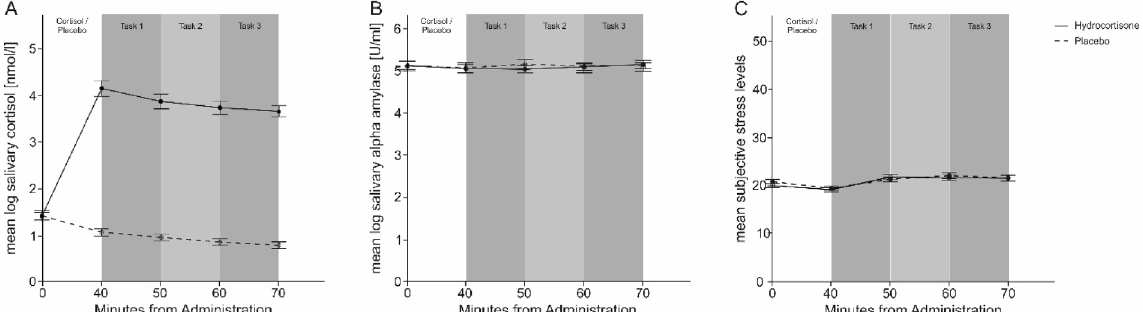
Figure 2. Physiological and subjective reactions during hydrocortisone and placebo treatment. Error bars represent 1 ± SEM from the mean. ( A ) Mean cortisol responses in relation to measurement time point with logarithmized data. Cortisol levels were increased in the hydrocortisone group from the second measurement time point onwards. ( B ) Mean salivary alpha amylase response in relation to measurement time point with logarithmized data. No changes in sAA levels were observed between the hydrocortisone and control group across the experiment. ( C ) Mean subjective stress responses measured by SERS in relation to measurement time point. No differences in SERS levels were observed between the hydrocortisone and control group across the experiment.